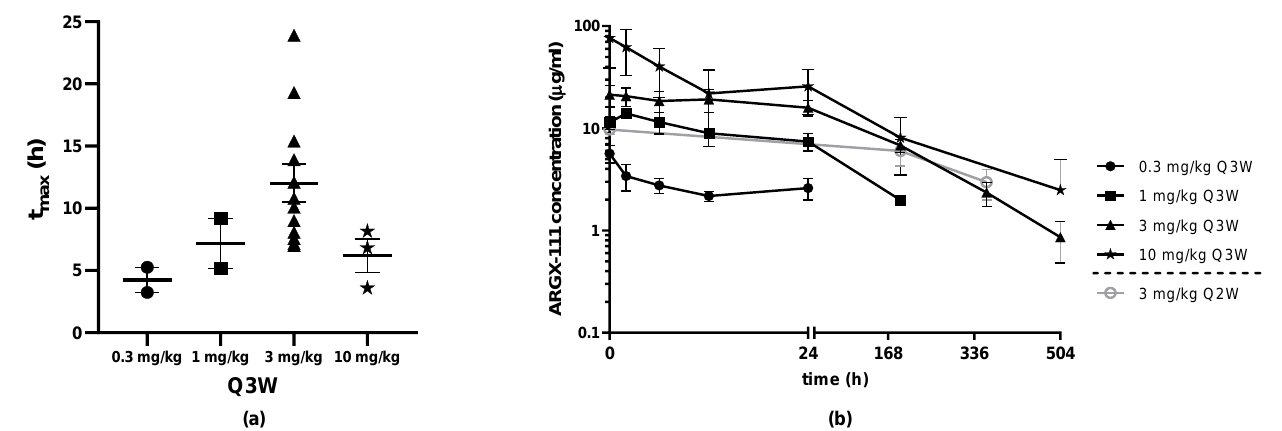
Figure 3. PK analysis of ARGX-111 at C1. ( a ) Mean serum concentration over time after IV infusion of ARGX-111 by dose level; ( b ) Mean time taken to reach peak serum concentration (t max ) by dose level for DE (Q3W: 0.3 mg/kg (N = 2); 1 mg/kg (N = 2); 3 mg/kg (N = 12); 10 mg/kg (N = 3); Q2W: 3 mg/kg (N = 5)). Graphs represent mean ± SEM.